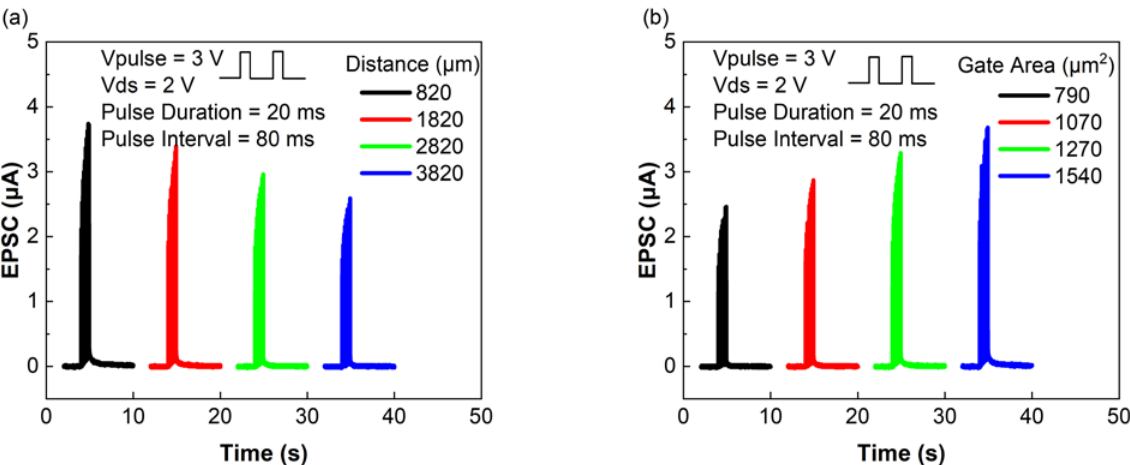
Figure 7. EPSC curves of the multi-gate EDLT when the consecutive pulses are added on the planar gate electrodes with ( a ) different distances to the channel, ( b ) different areas.